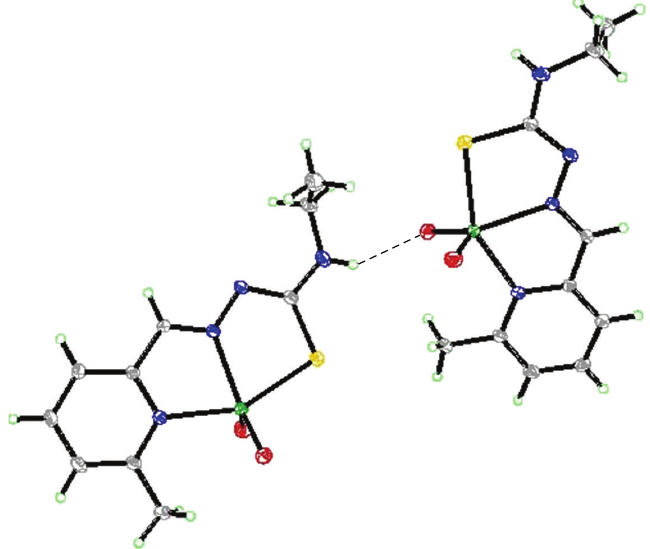
Figure 3: Hydrogen bonding interaction in the lattice of [VO 2